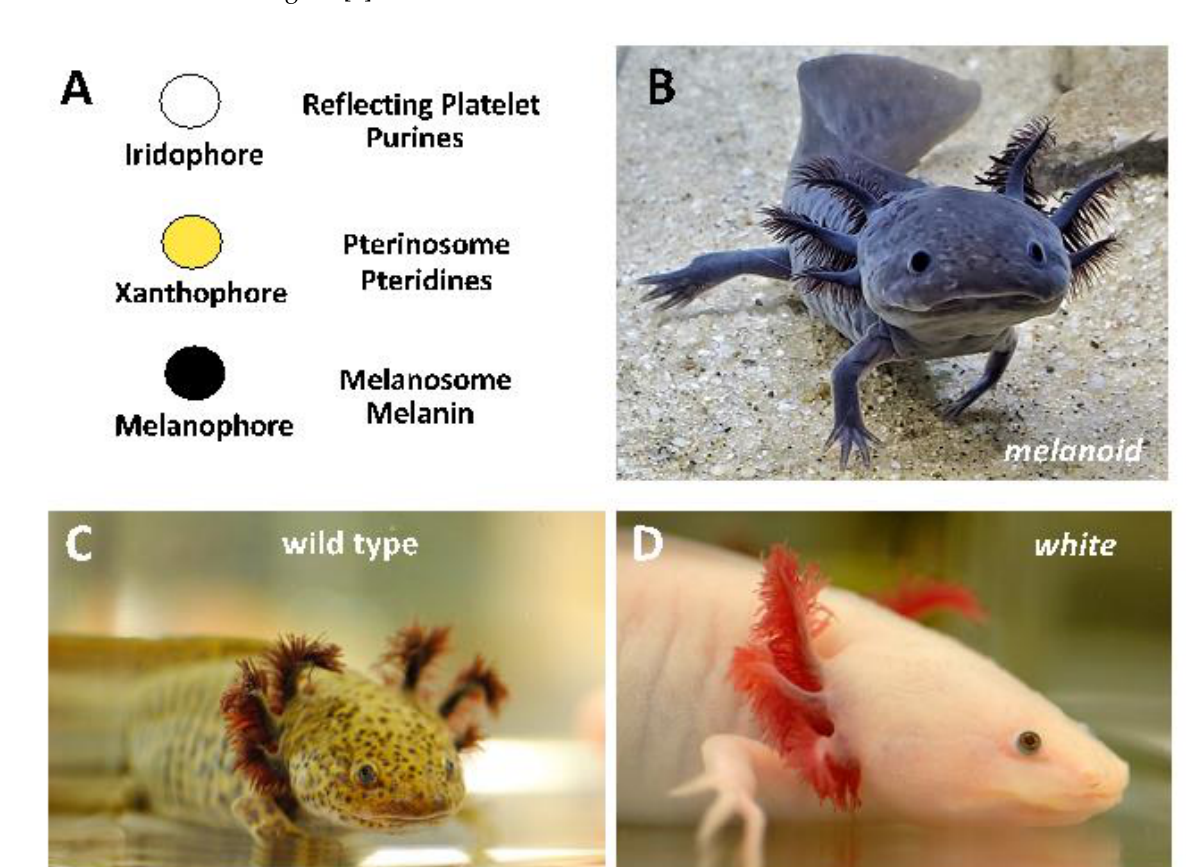
Figure 1. ( A ) The relative numbers of pigment cell types explain axolotl color variants. Iridophores